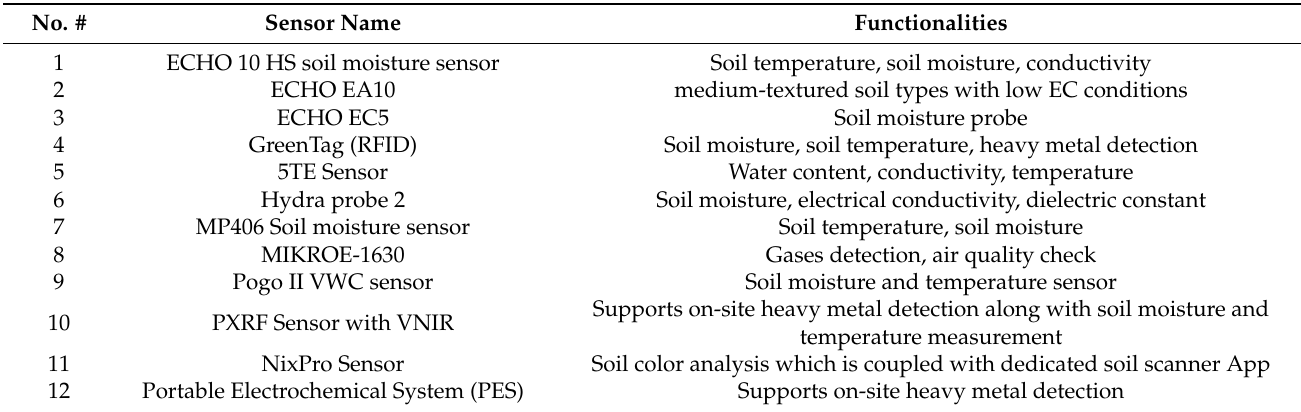
Table 2. Sensors used in the agriculture